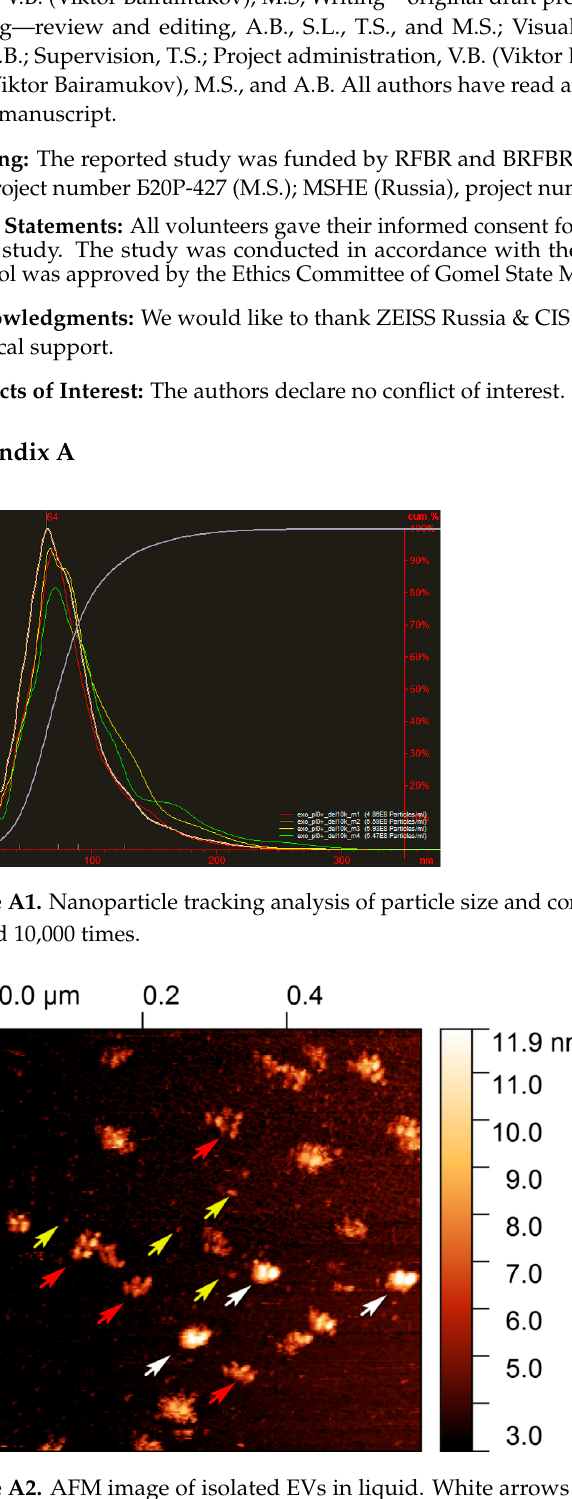
Figure A2. AFM image of isolated EVs in liquid. White arrows indicate exosomes; yellow arrows indicate the single exomeres while red arrows indicate the exomeres, and the nanofilament revealed a “string of beads” morphology. Scan size 600 × 600 nm 2 .